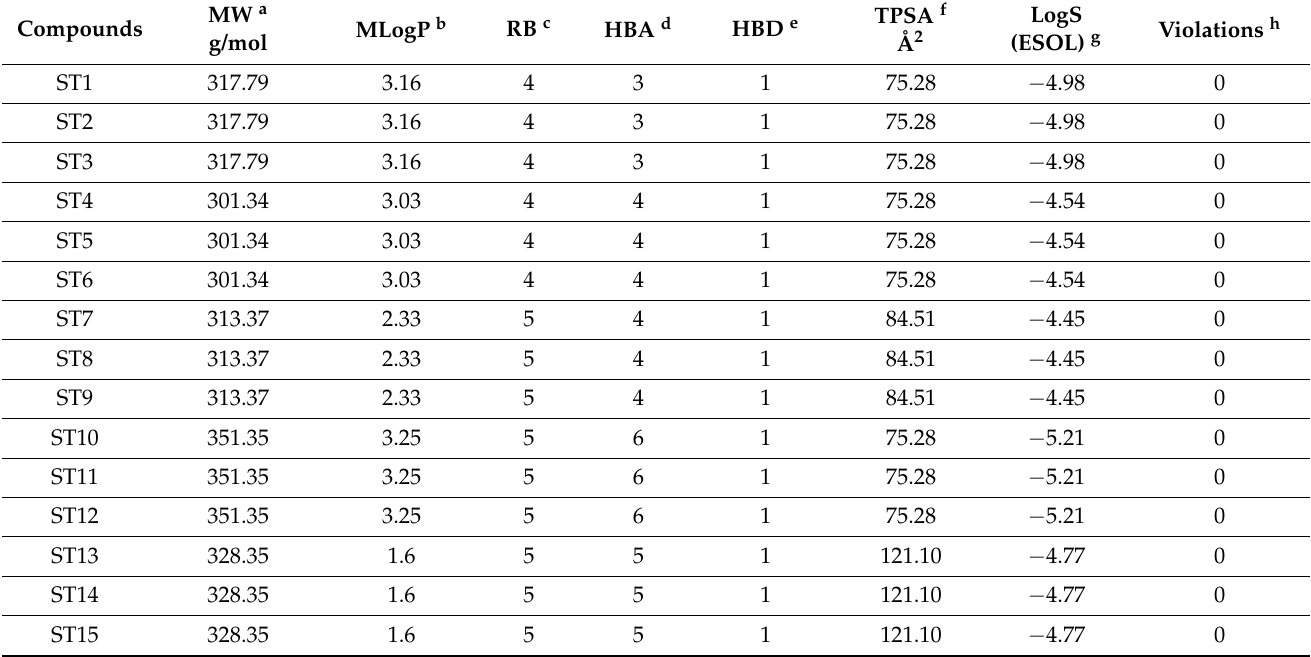
Table 3. Prediction of the molecular descriptors (Lipinski rules of five) for compounds ST1 – ST15 by Swissadme.